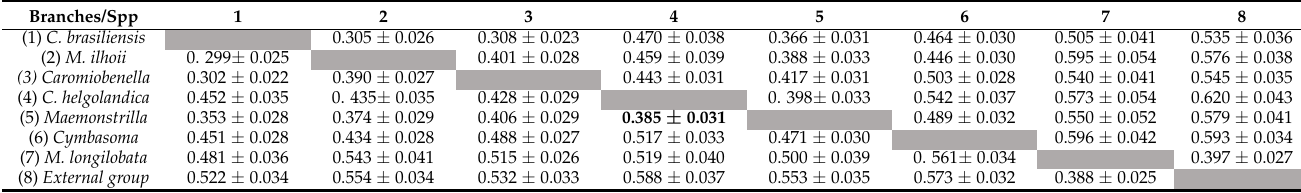
Table 5. Mean pair-wise genetic distances over 582 pb COI fragment among different monstrilloid genera or branches as shown in Figure 6 for the comparisons with Brazilian copepods from Rio de Janeiro coast. See Table S1 for sequences obtained from GenBank. Distances: (below the diagonal) Kimura-2 Parameter; (above the diagonal) Tamura–Nei distance.